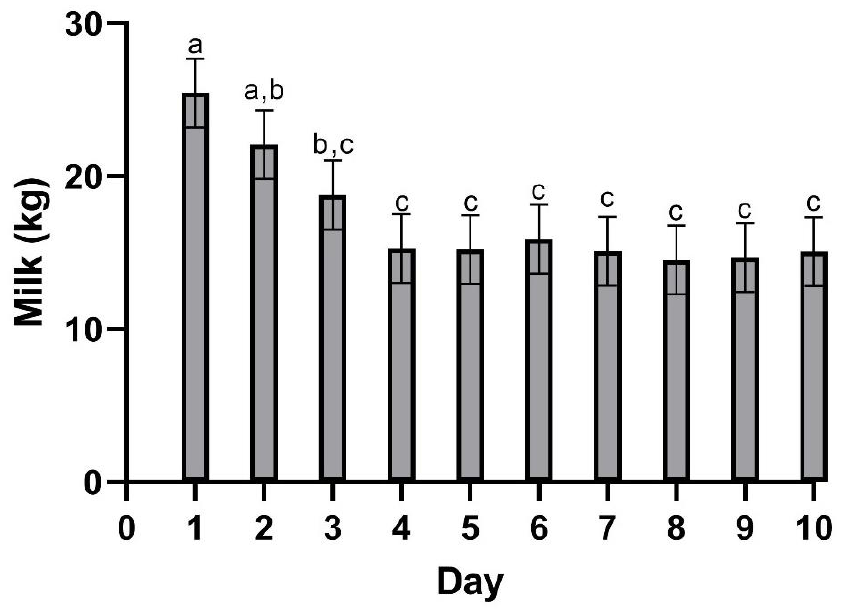
Figure 1. Mean ( ± SEM) milk production following a single oral dose of meloxicam at 30 mg/kg. Figure 1. Mean (±SEM) milk production following a single oral dose of meloxicam at 30 mg/kg. a,b,c a,b,c Different letters above data bars are statistically significant ( p = Different letters above data bars are statistically significant ( p = 0.001).